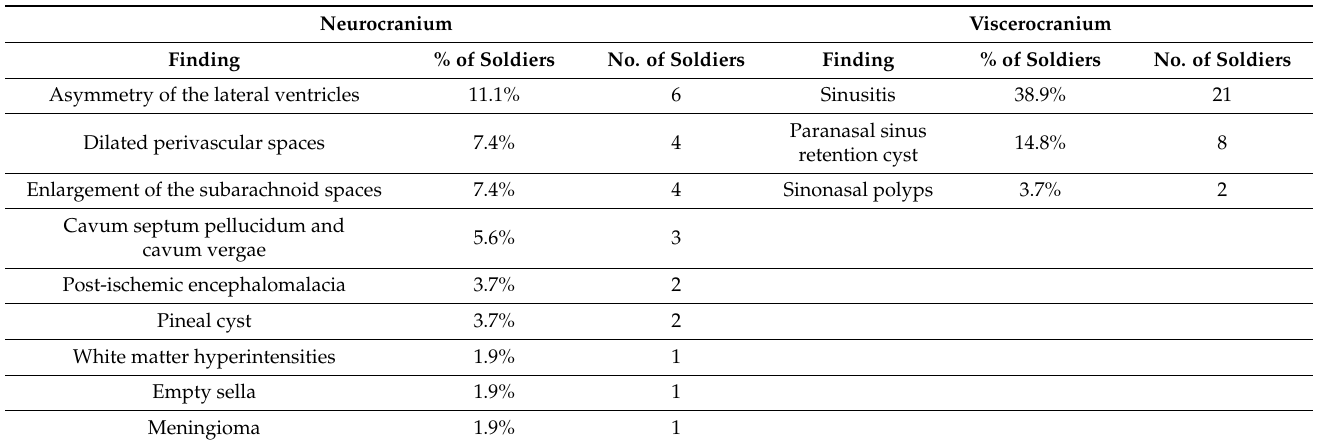
Table 2. Anatomic variations and abnormalities observed in magnetic resonance imaging examina- tions of the heads of soldiers.